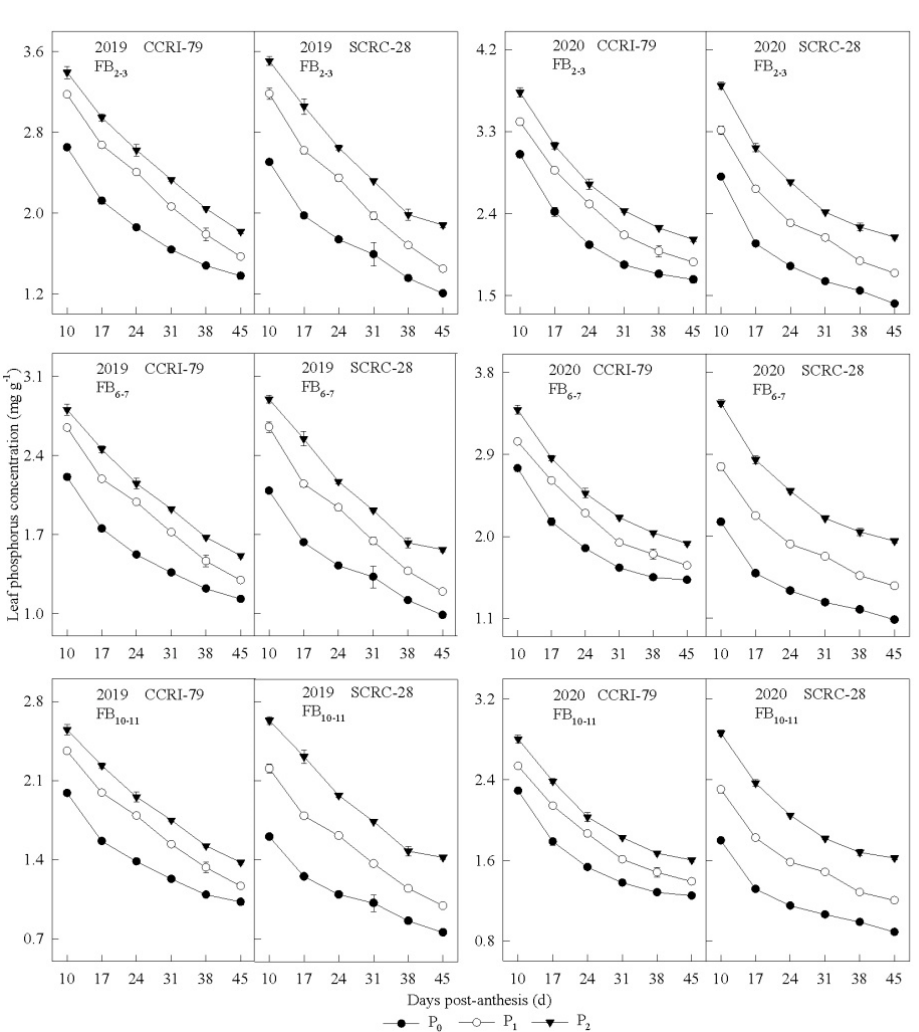
Figure 2. The effect of soil available phosphorus (AP) contents on the phosphorus (P) concentration in the subtending leaves during the 2019–2020 cotton-growing seasons. d: day. FB: fruiting branch. P 0 : 3 ± 0.5 mg kg − 1 . P 1 : 6 ± 0.5 mg kg − 1 . P 2 : 15 ± 0.5 mg kg − 1